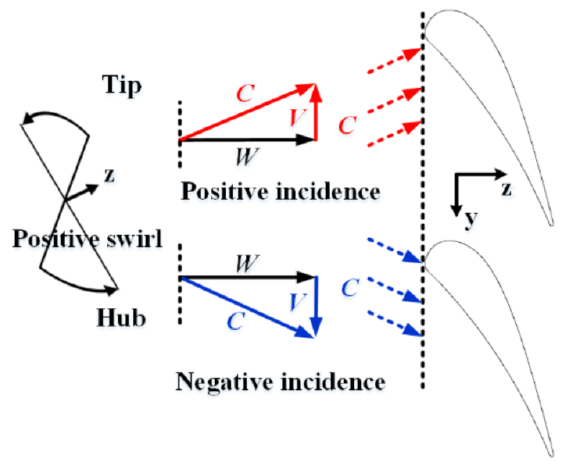
Figure 11. Limited streamlines on NGV surfaces.